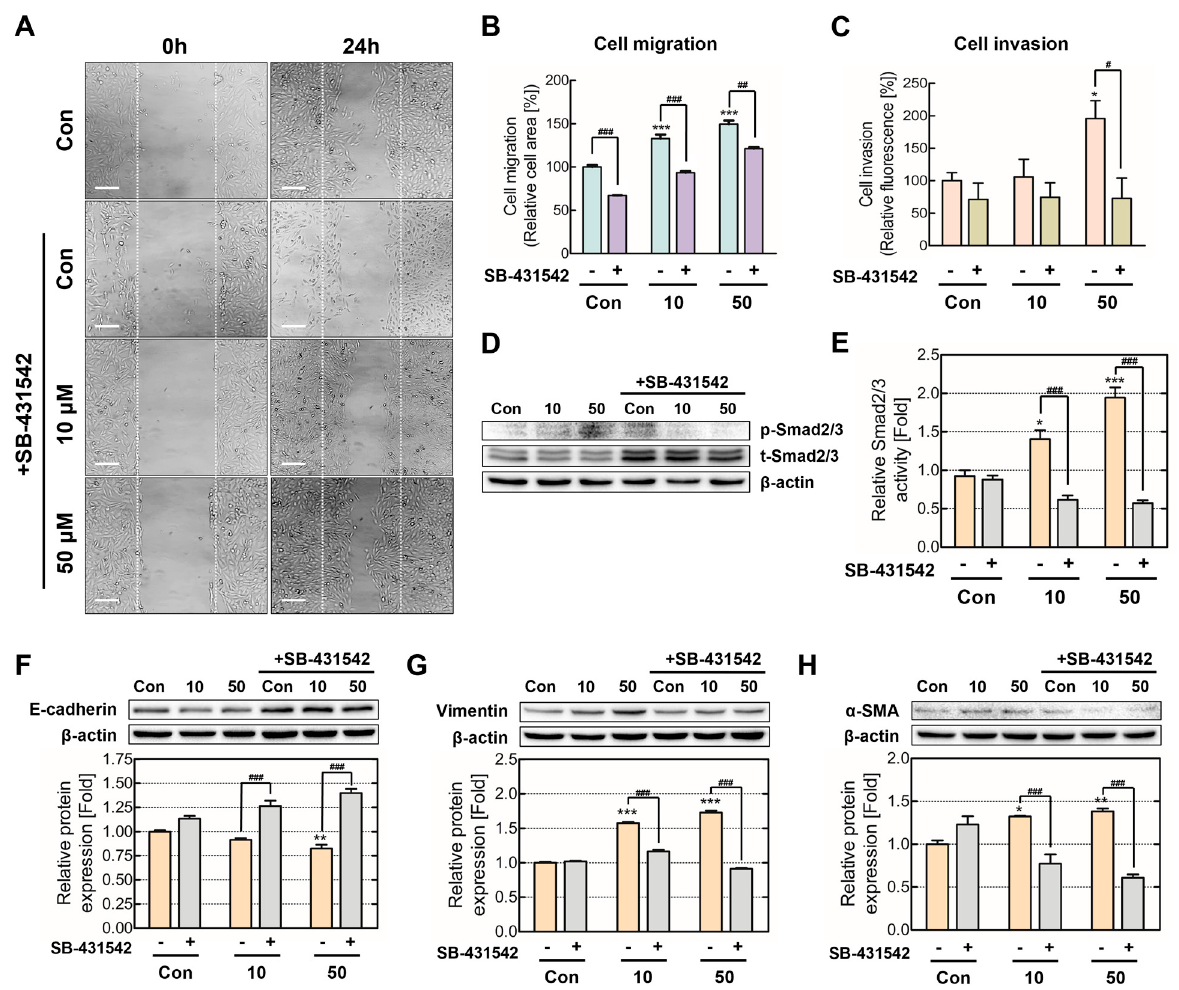
Figure 5. Cell metastasis and EMT attenuation in chronic TDI exposure via TGF- β antagonists. To validate TGF- β 1/SMAD axis regulatory effects, the chronic TDI exposure model was co-treated with TDI and the TGFBR-specific antagonist SB-431542. ( A ) Migration was observed through microscopy after TDI and TGF- β antagonist co-treatment. ( B ) The bar graph represents quantified values. ( C ) Cells basement membrane permeability was measured using a fluorescence reader after TDI and TGF- β antagonist co-treatment. ( D ) p-SMAD2/3 and SMAD2/3 protein expression levels were measured. ( E ) SMAD2/3 activity was calculated through phosphorylated-SMAD/total-SMAD quantification. ( F ) E-cadherin, ( G ) vimentin, and ( H ) a-SMA protein expression levels were measured. Every experiment was performed over three times. * p < 0.05; ** p < 0.01; *** p < 0.001 compared to the control group; # p < 0.05; ## p < 0.01; ### p < 0.001 compared to SB-431542 untreated group; Con: control; 10: 10 μ M of TDI; 50: 50 μ M of TDI; Scale bars: 200 μ m.